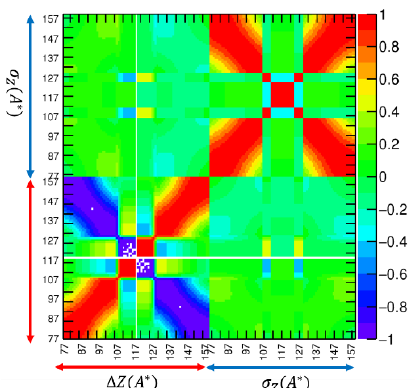
Fig. 6. The correlation matrix of the Wahl-like